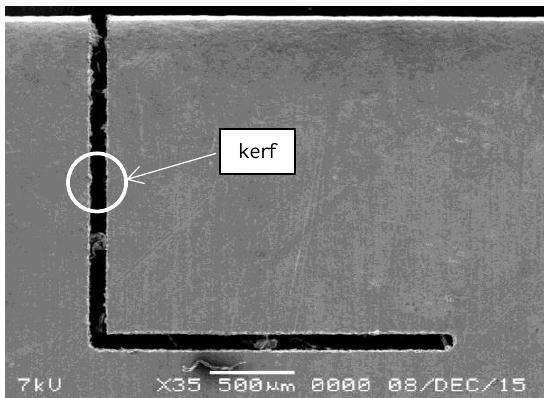
Figure 4: SEM micrograph of kerf produced by micro-WEDM with 70 µm diameter tungsten wire